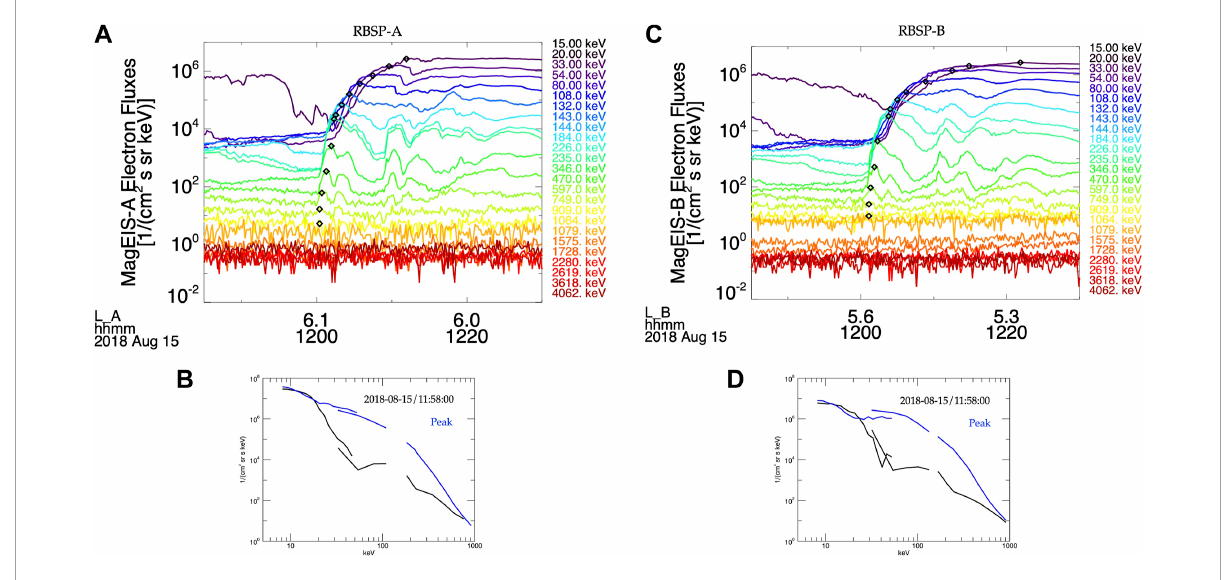
FIGURE 2 Energetic electron flux from the MagEIS instrument for the same event as Figure 1 from RBSP-A on the left and RBSP-B on the right. The diamonds show the time of peak flux at each energy channel. Below the lineplots are energy spectra from before the injection and the peak of the injection in each energy channel.